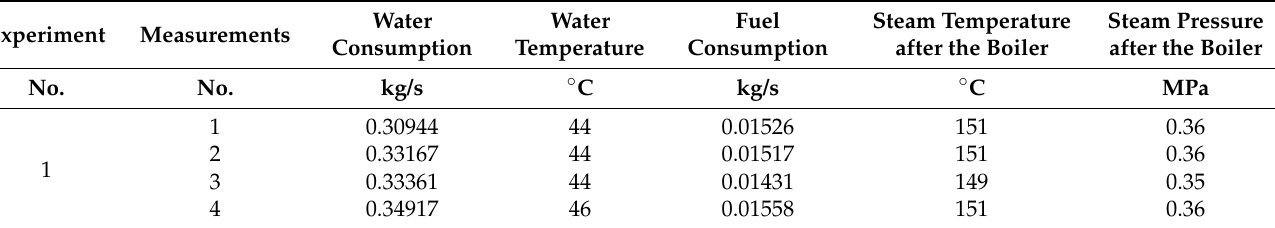
Table 3. Experimental values of Steam boiler 1.